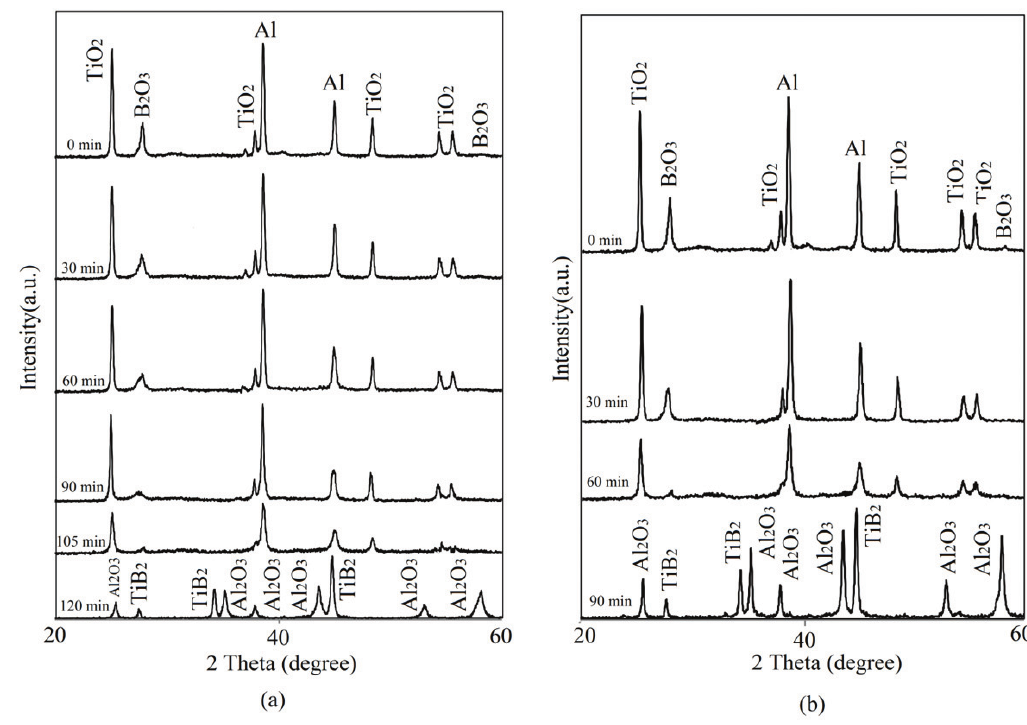
O and TiO milled powders in a) system 1; b) system 2. 2 3 2